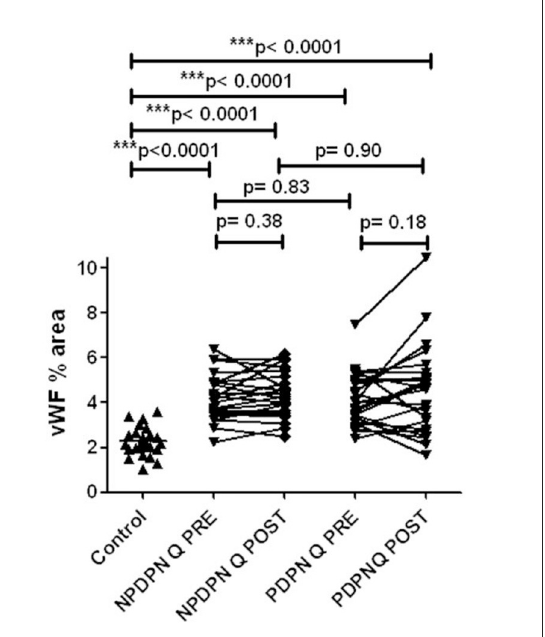
FIGURE10 vWF immunohistochemistry in skin biopsies in non–painful (NPDPN Q + SOC) and painful (PDPN Q + SOC) Diabetic Peripheral Neuropathy following Capsaicin 8% patch Qutenza (Q) treatment. Vessel density (vWF, % area) in NPDPN Q + SOC and PDPN Q + SOC at baseline (Q PRE) and statistically no significant differences between NPDPN and PDPN before (Q PRE, p = 0. 83; Mann–Whitney test; n = 24 NPDPN Q + SOC) or 3 months after treatment (Q POST, p = 0. 90, Mann–Whitney test). Statistically significant increases (all *** p < 0.0001, Mann–Whitney test) between control group and baselines (Q PRE) or 3 months after treatment (Q POST) in both NPDPN Q + SOC and PDPN Q +